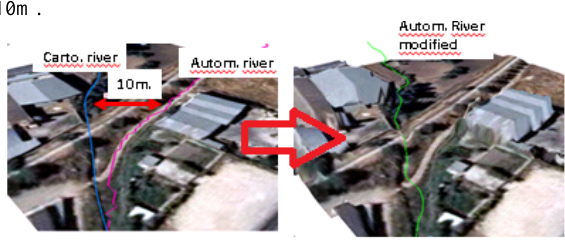
Figure 10. Obstacles correction 2 (bridges from LiDAR) Lift correction